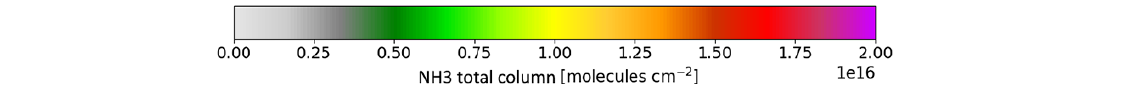
Figure A1. IASI-A NH 3 5-year mean (2013–2017) total column (moleculescm − 2 ) distribution at 0.05 ◦ × 0.05 ◦ (long, lat) resolution, The source locations with successful emission estimates are shown by black circles centered around the source